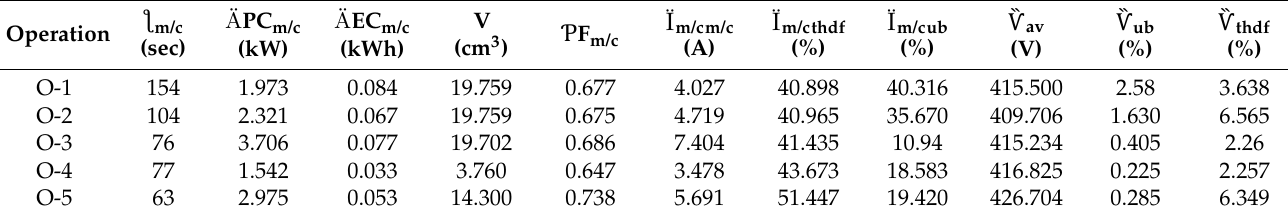
Table 6. Experimental observations of the actual cut (machining).